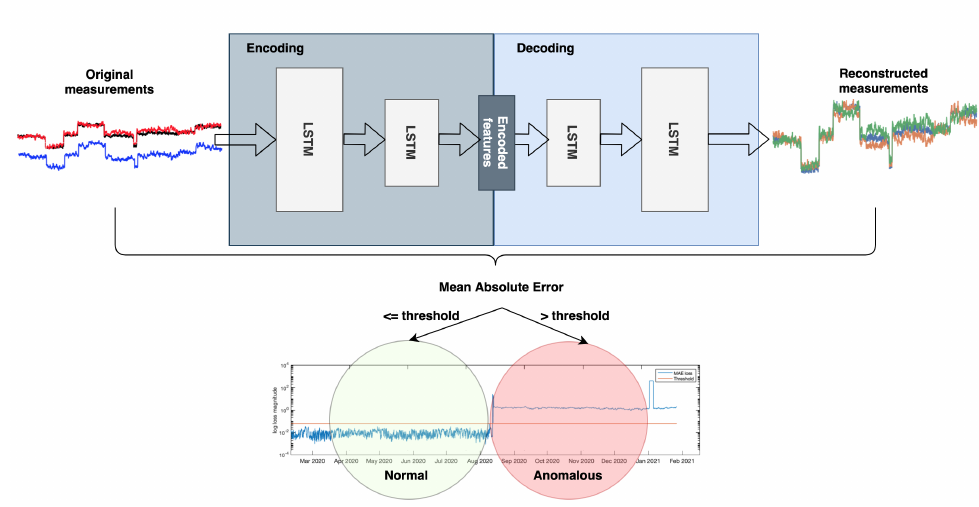
Figure 3. Long Short-Term Memory Auto—Encoder Network